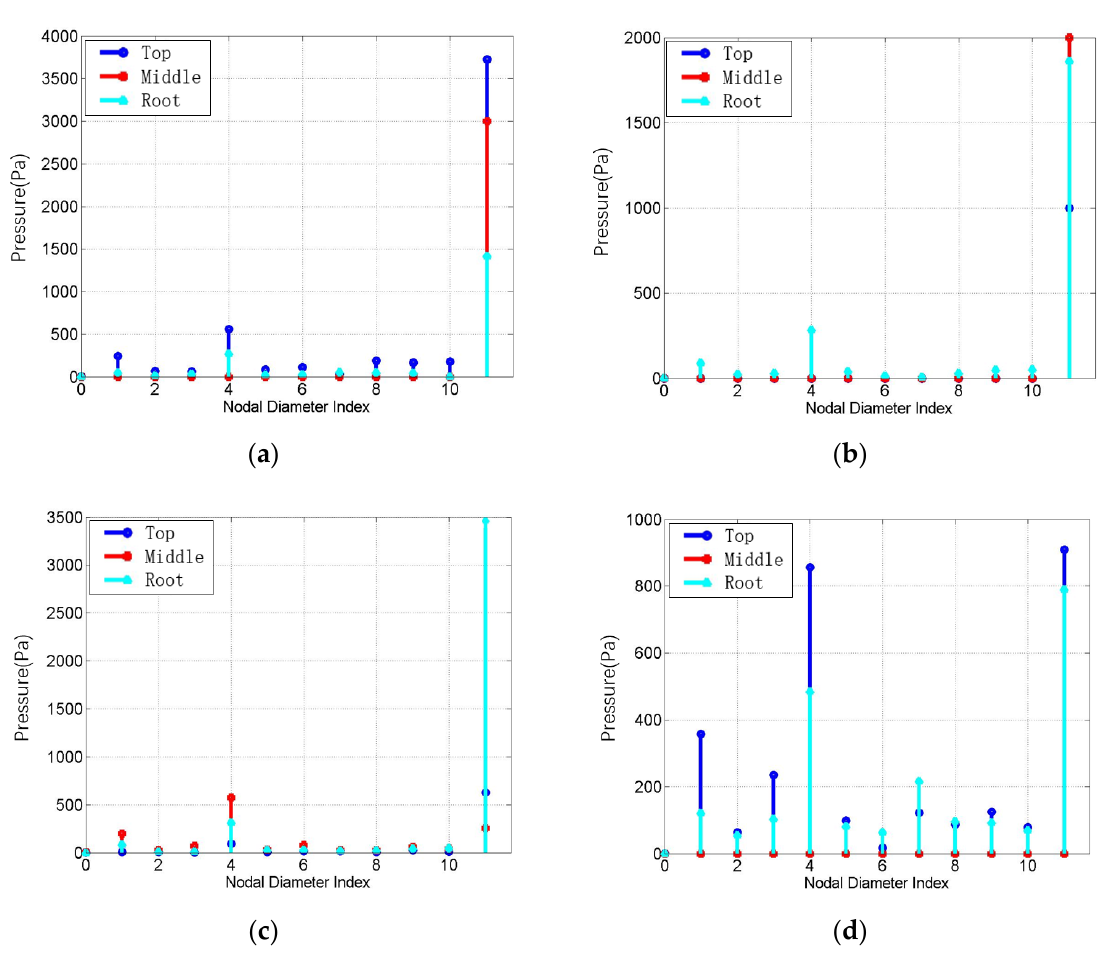
= N ) at: ( a ) the leading s